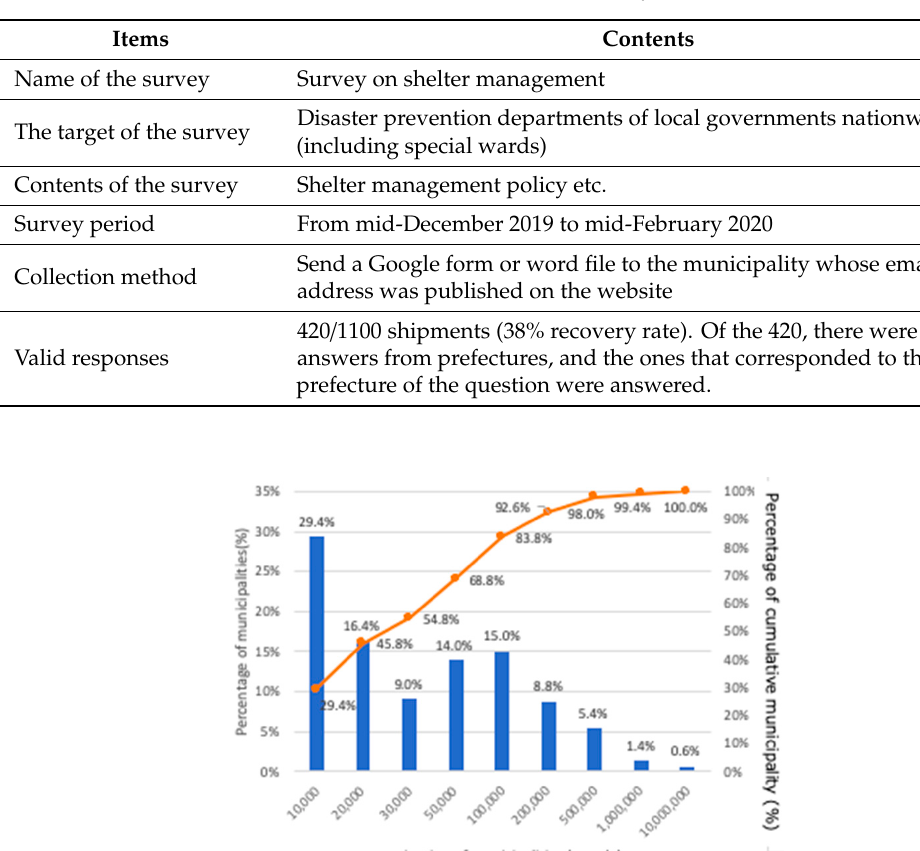
Table 1. Outline of the survey.